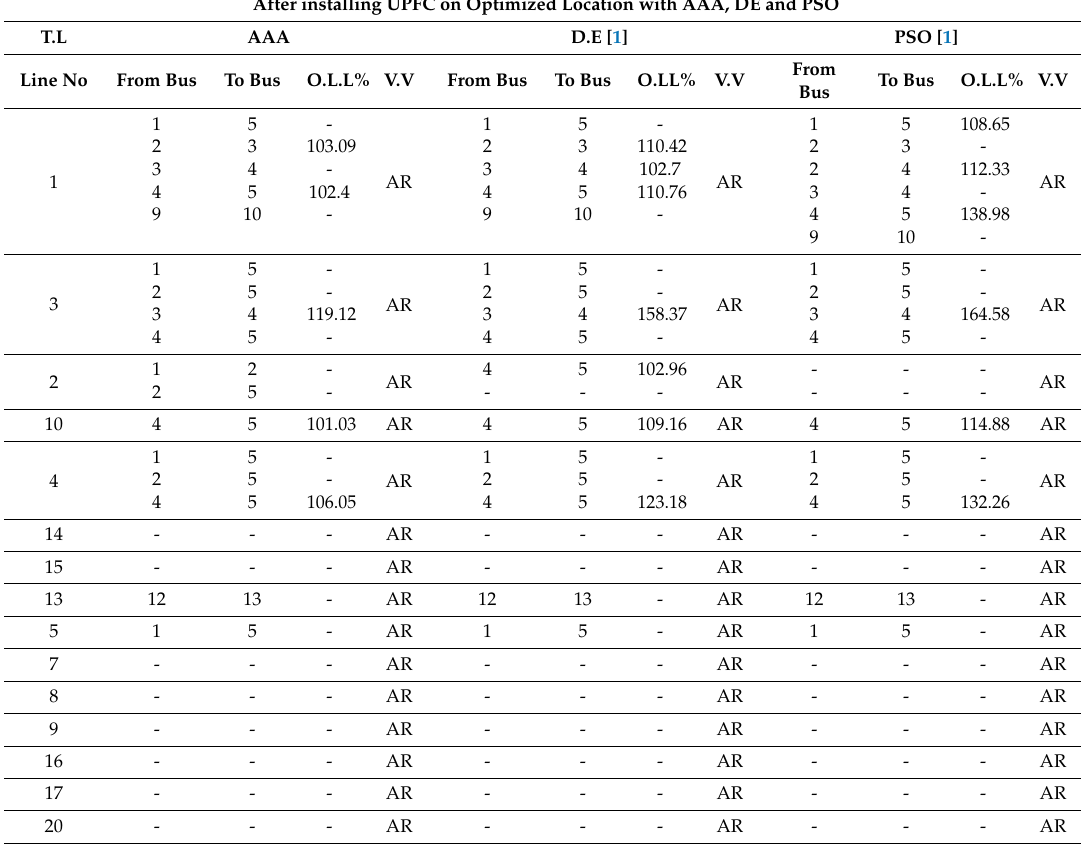
Table 5. Overloading of lines and voltage violations using UPFC at optimized location by AAA, D.E and PSO.